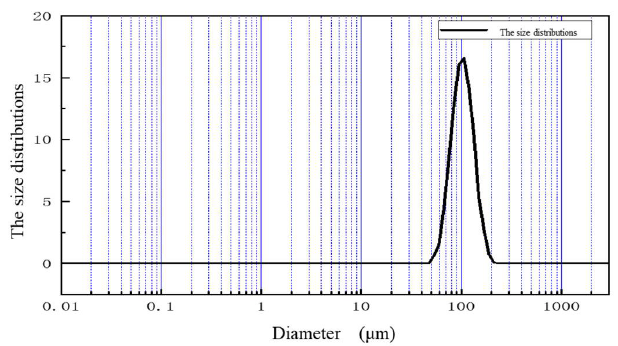
Figure 8. The size distributions of three kinds of coal particles.